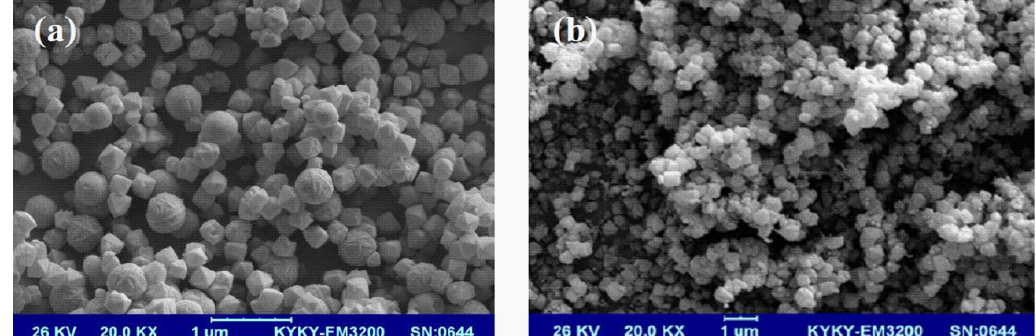
Fig. 5. SEM images of NaY before and after TEPA loading (a): NaY, (b) TEPA-